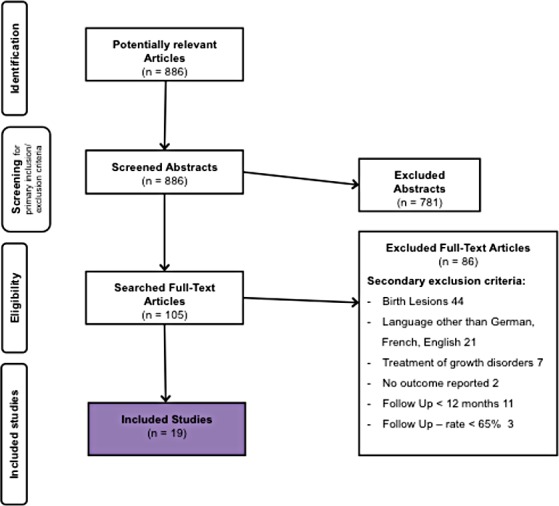
Flow chart of the search strategy and study selection.Criteria for drop-out and subsequent number of studies remaining for further analysis.